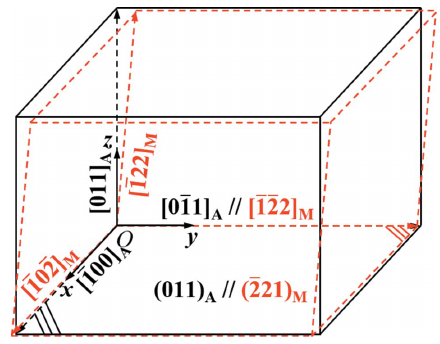
Figure 7 Lattice correspondences between the parent austenite (black) and the product martensite (red) under the Pitsch